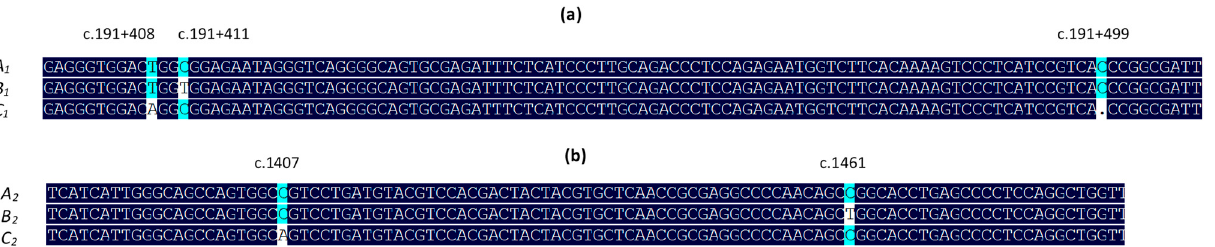
Figure 2. Nucleotide sequence comparisons of the ovine DGAT1 variants. Three variants in intron 1 ( a ) and three variants in exon 17 ( b ) were detected. Only the nucleotides in the variable region are shown. Nucleotides with high levels of homology are colored, with black indicating 100% homology and blue indicating ≥ 50%. Positions of nucleotide differences are indicated.